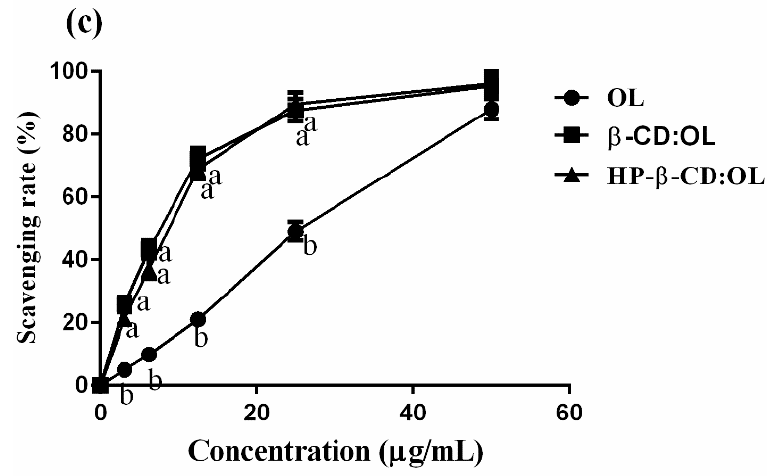
Figure 5. Comparison of OL, HP-beta-CD:OL and beta-CD:OL: the number of reactive phenol hydroxyls ( a ), scavenging rates against DPPH ( b ) and ABTS + radicals ( c ). The reactive phenol hydroxyls were estimated via the ferric reducing power of the samples. The letters a, b, and c represent significant differences ( p < 0.05 in ( a ), p < 0.01 in b , c ).